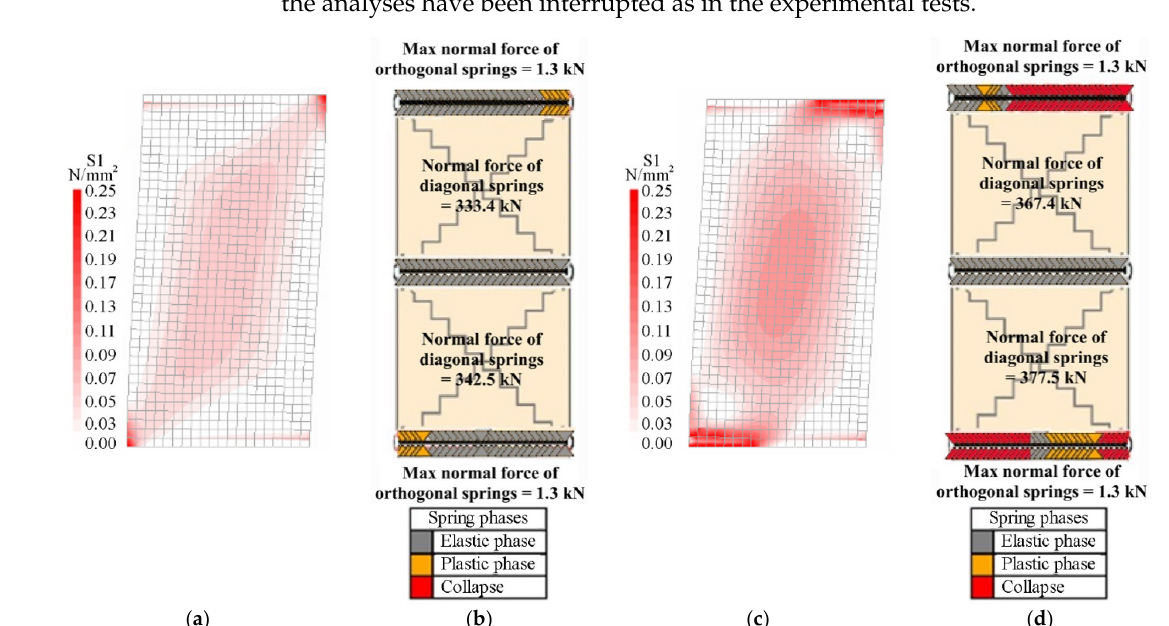
Figure 6. Distributions of the principal stresses and normal forces into the slender masonry panel at the end of the elastic field: ( a ) FEM, ( b ) DMEM, and at the peak load step: ( c ) FEM, ( d ) DMEM.